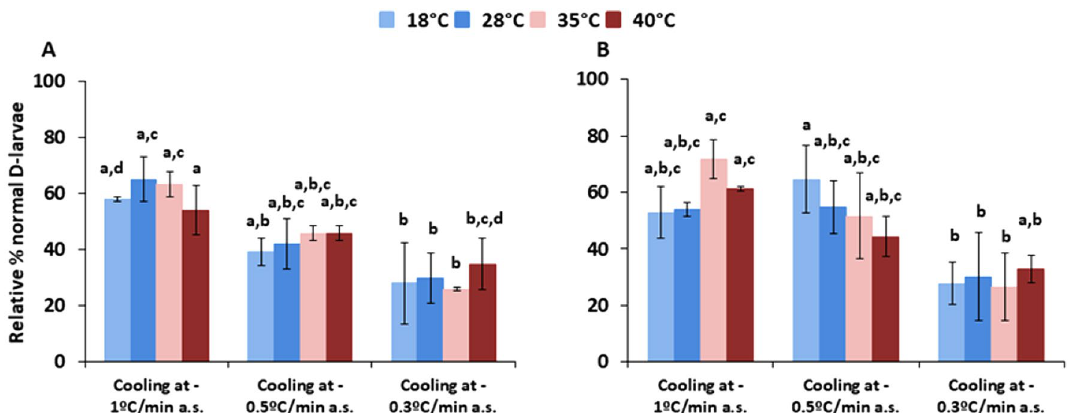
Figure 3. Relative percentage of M. galloprovincialis normal D-larvae compared to control group developed from cryopreserved trochophores ( A ) and 72 h-old D-larvae ( B ) using different cooling rates after the seeding (a.s.) check (− 1 °C/min, − 0.5 °C/min and − 0.3 °C/min) tested in combination with increasing thawing baths at 18 °C, 28 °C, 35 °C and 40 °C for melting the ice. Results are expressed as Mean ± Standard Deviation (SD), n = 100, 3 replicates per treatment. Letters show significant differences between treatments (p <